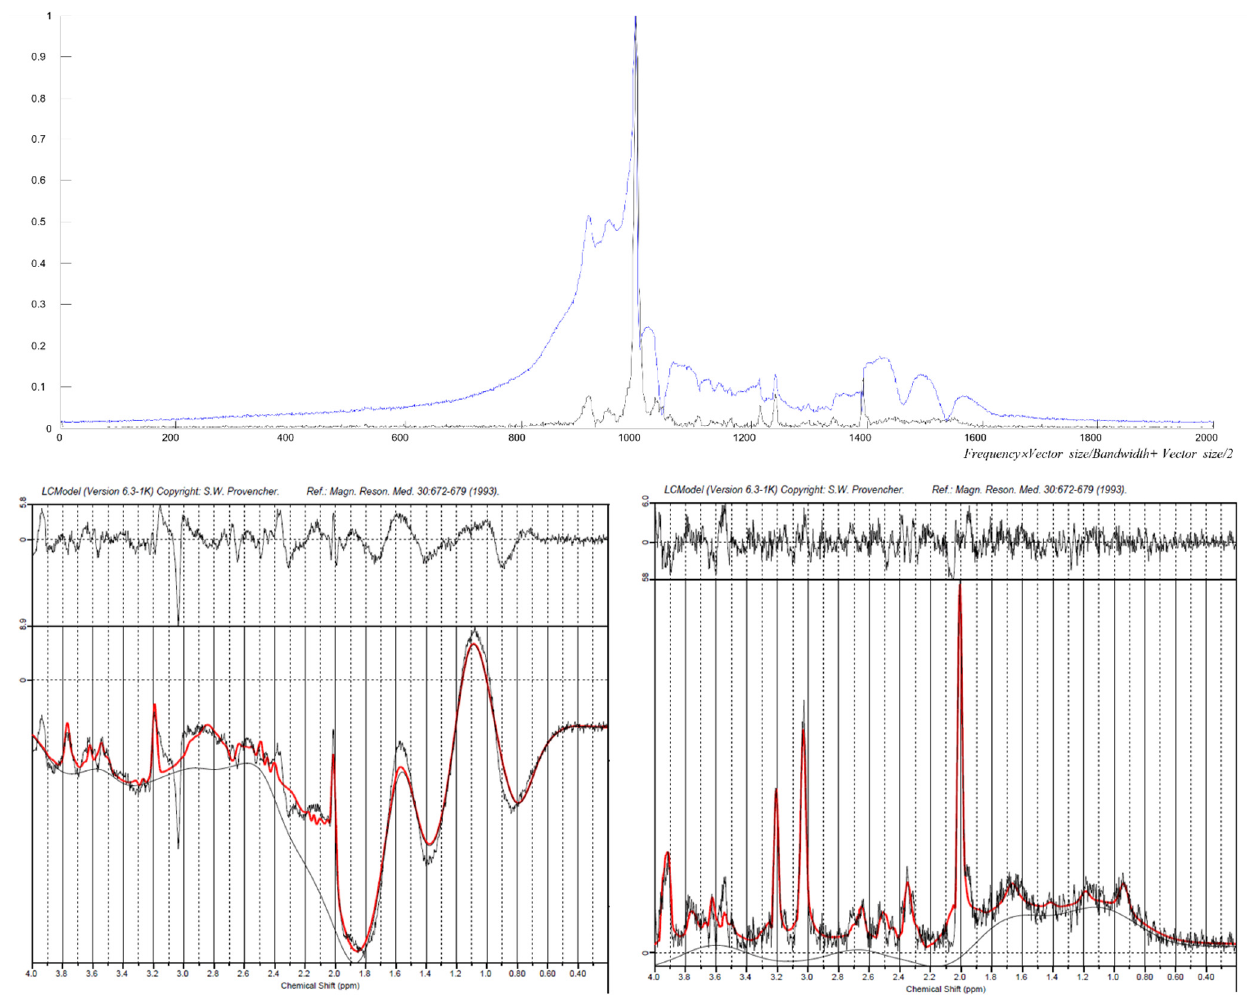
Figure 5. Comparing the spectral signal at the center voxel (8,8) before and after differential filtering. The upper graph indicates the absolute value data before differential filtering (blue) and after differential filtering (black). The y -axis is the standardized value of the spectral signal with the maximum, and the x -axis is the number of data points. The pictures on the left and right at the bottom are the LCModel analysis data results from un-preprocessed complex number data and differential filtered absolute value data, respectively.